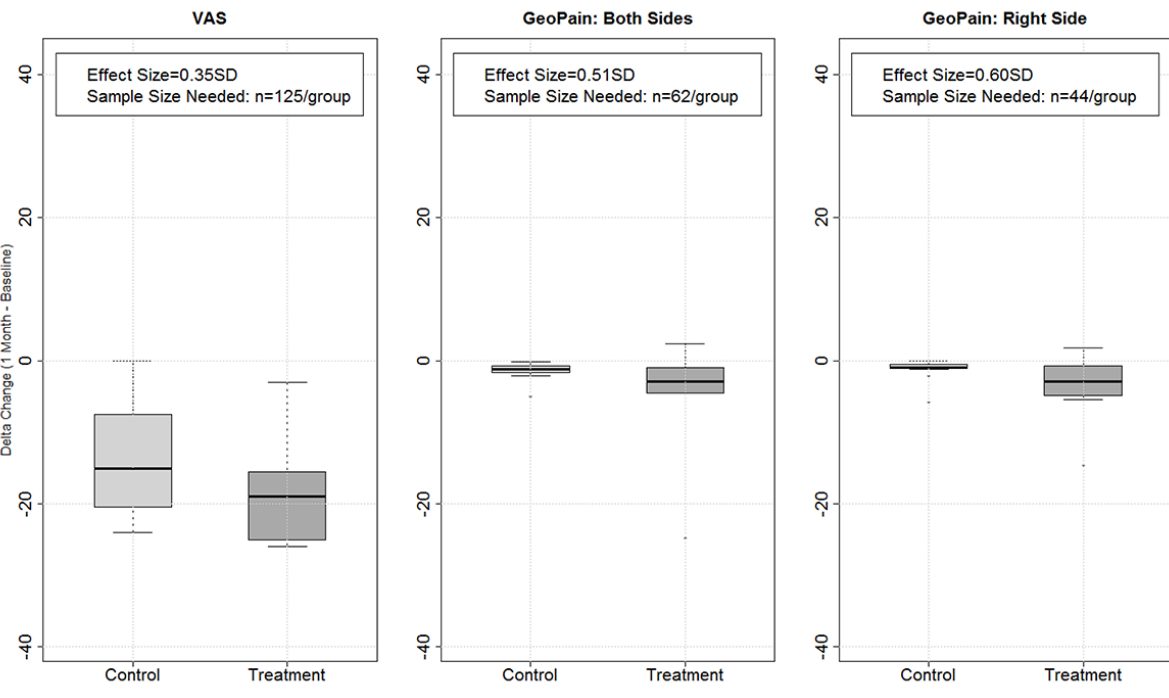
Figure 6. Graphs showing the power between the GeoPain × VAS. This figure shows the box plot for delta change by treatment and the corresponding effect sizes based on PAINS and VAS. The effect sizes for PAINS are larger than those for VAS, consequently requiring smaller sample sizes to assess the utility of treatment if PAINS is used versus VAS. Specifically, the effect sizes for PAINS were 0.51 SD for both regions and 0.60 SD for right side versus 0.31 SD for VAS. Thus, the sample size required to detect such effect sizes with 80% power would be n=145 per group for VAS, but for PAINS n=62 per group if both sides were used, n=44 per group for the right side, and n=82 per group for the left. PAINS: pain area and intensity number summation; VAS: visual analog